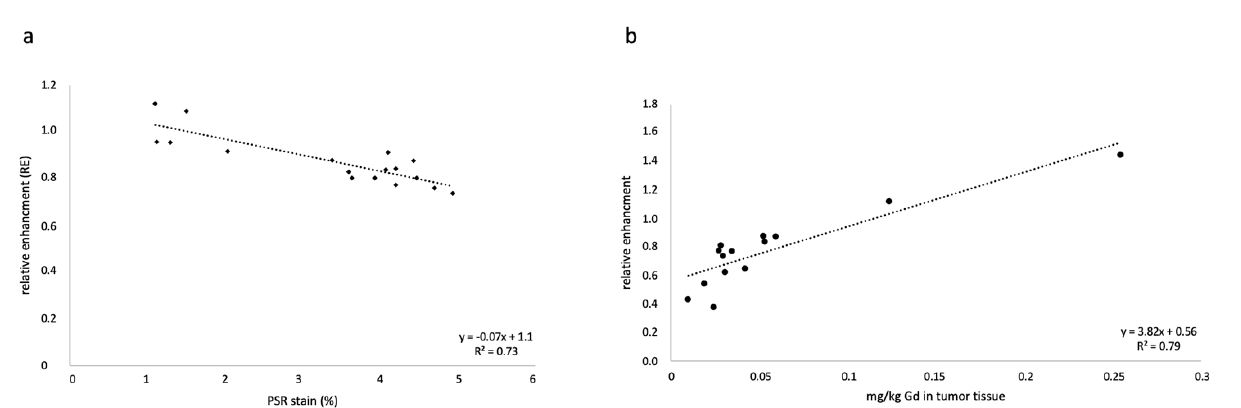
Figure 5. Correlation of the MRI data and the histological and elemental analysis. ( a ) The correlation between the percentage of stained collagen fibers by Picrosirius red (PSR) and the relative enhancements in MRI show a good correlation (y = −0 .068x + 1.1; R 2 = 0.74). ( b ) shows a correlation between the relative enhancement and the ICP-MS analyses for Gd. A good correlation is shown (y = 3.82x + 0.56; R 2 = 0.79).